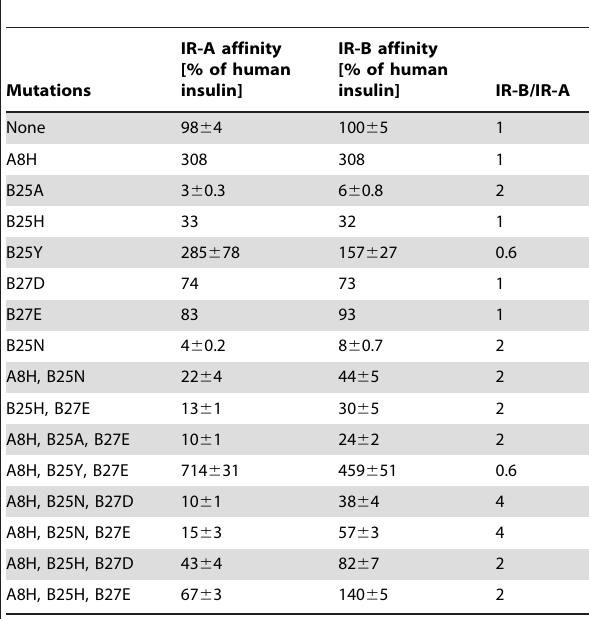
Table 1. Relative insulin receptor binding affinities of the